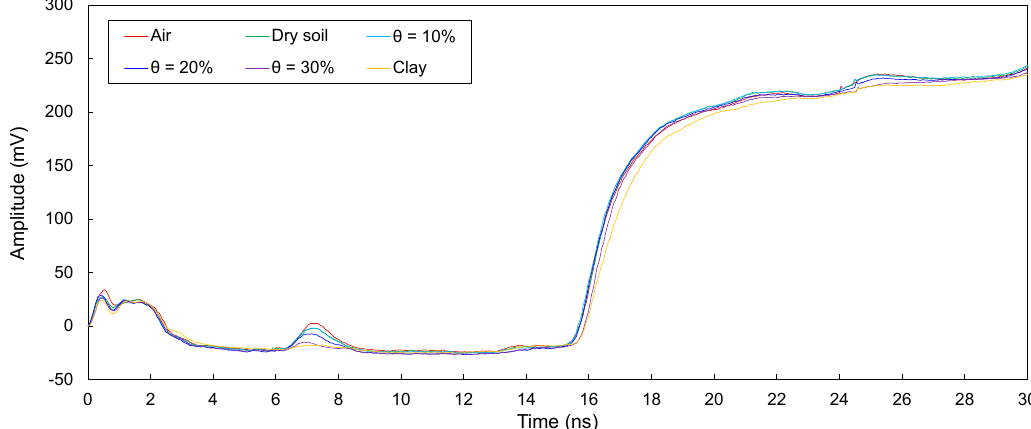
Figure 10. Measured signals for D3 with the defect filled with different materials of air; dry sand; wet sands with θ = 10%, 20%, and 30%; and clay.